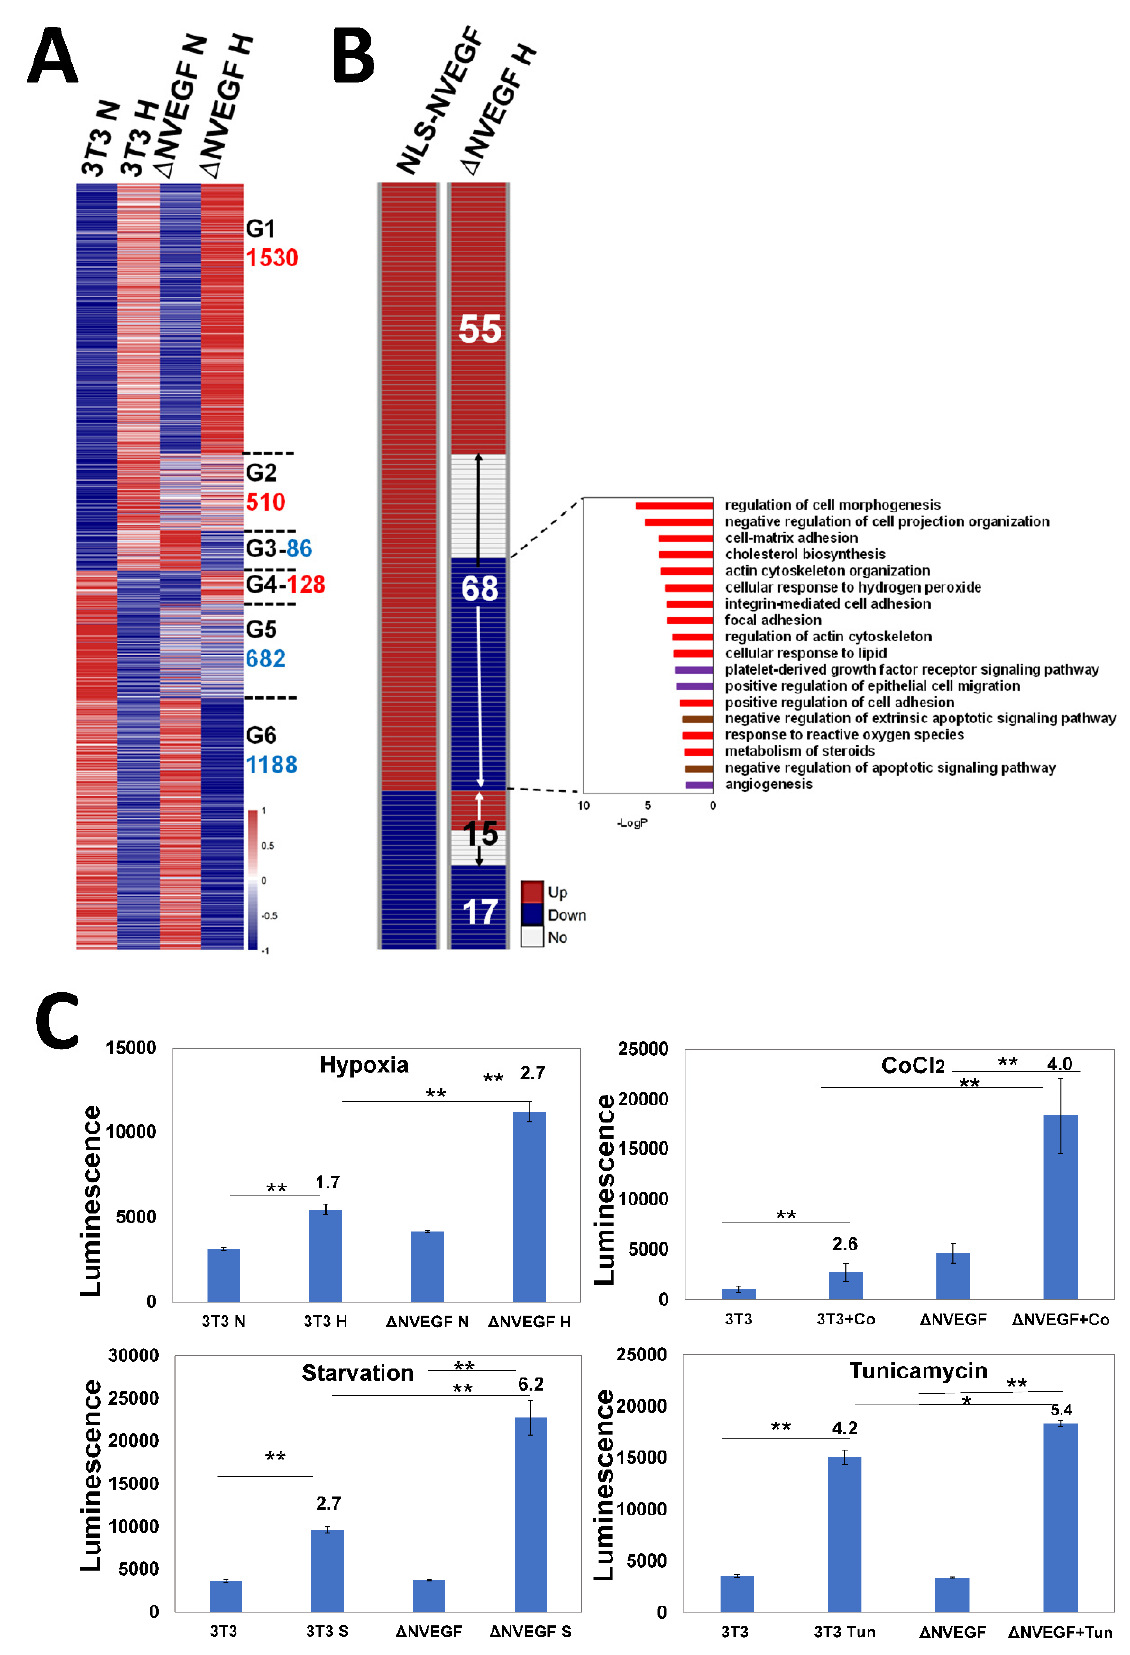
Figure 4. Impact of N-VEGF deletion on hypoxia-induced genes and on cellular physiology ( A ). Shown is a heatmap demonstrating gene expression levels in NIH3T3 cells (3T3) and ∆ N-VEGF